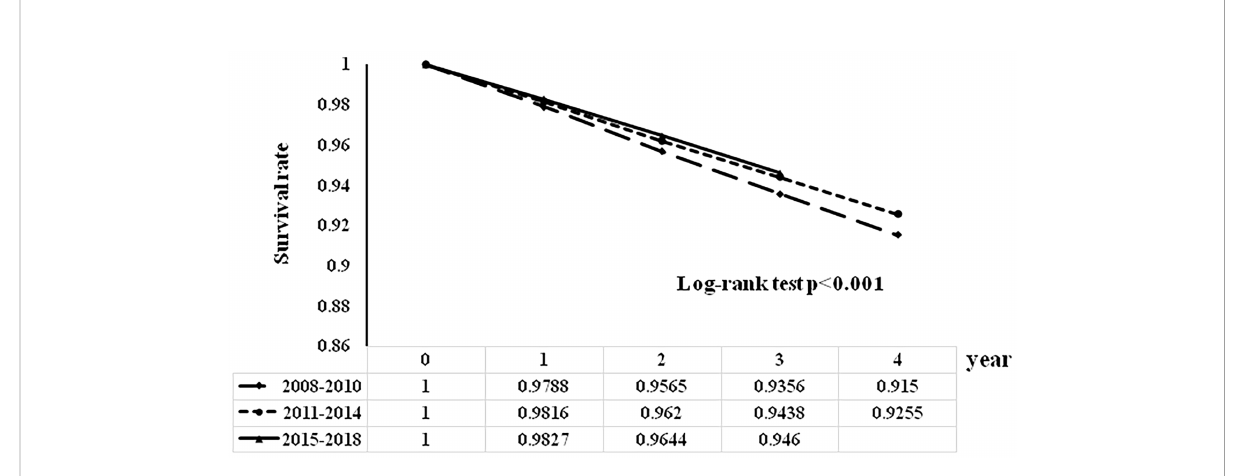
FIGURE 1 Survival rates after the diagnosis of diabetes by year of